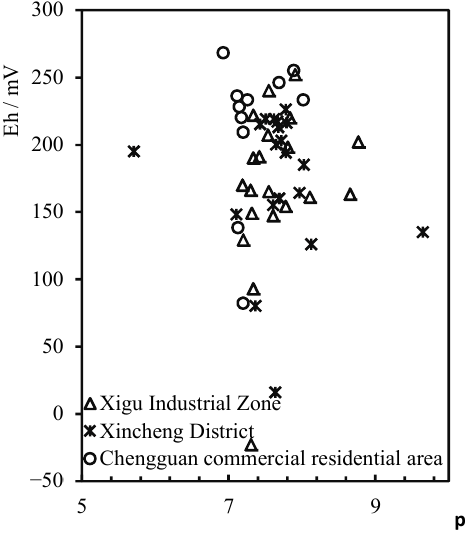
Figure 3. Eh–pH plots of the water samples in the study area.